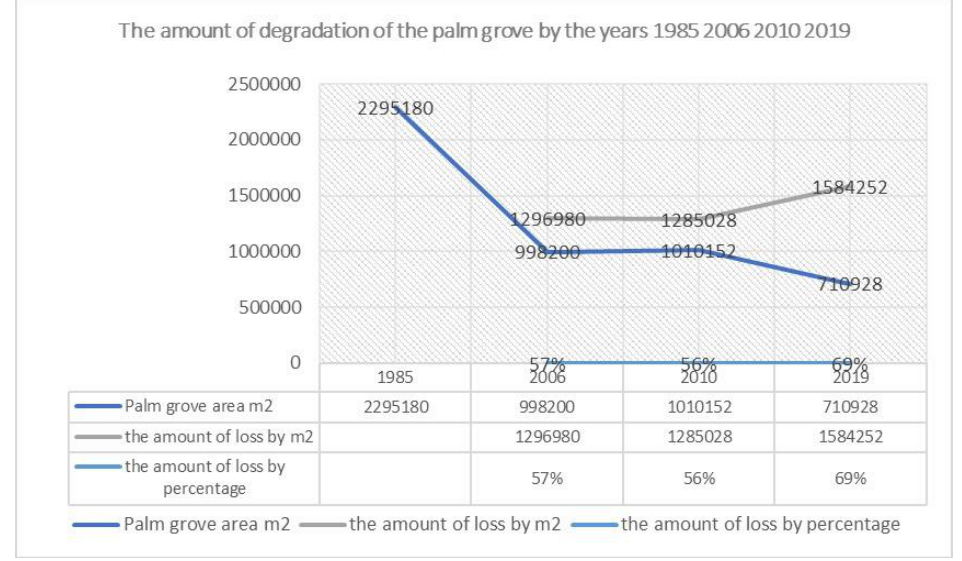
Figure 11 The amount of degradation of the palm grove areas by the years of 1985, 2006, 2010,